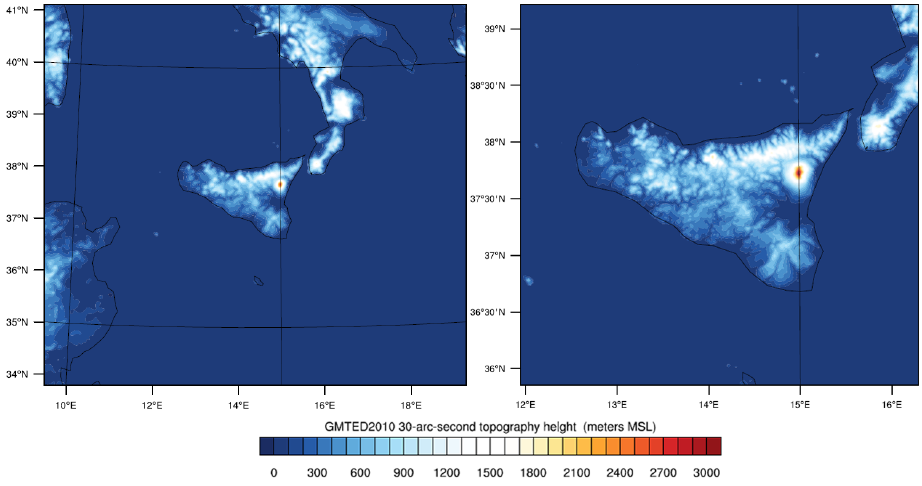
Figure 5. Orography resulting from the domains of 3 km ( left ) and 1 km ( right